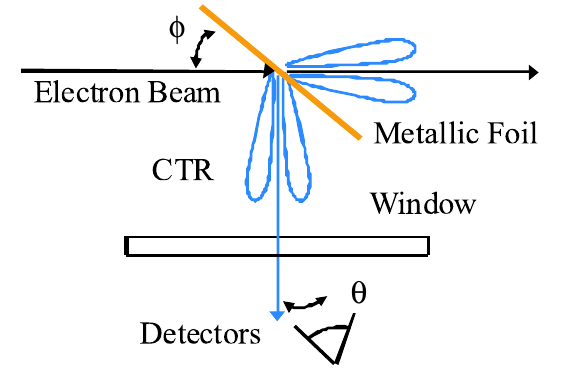
FIG. 1. (Color) Schematic of the experimental setup; (cid:1) (cid:2) 45 (cid:3) is the orientation angle of the foil with respect to the beam, and (cid:2) is the observation